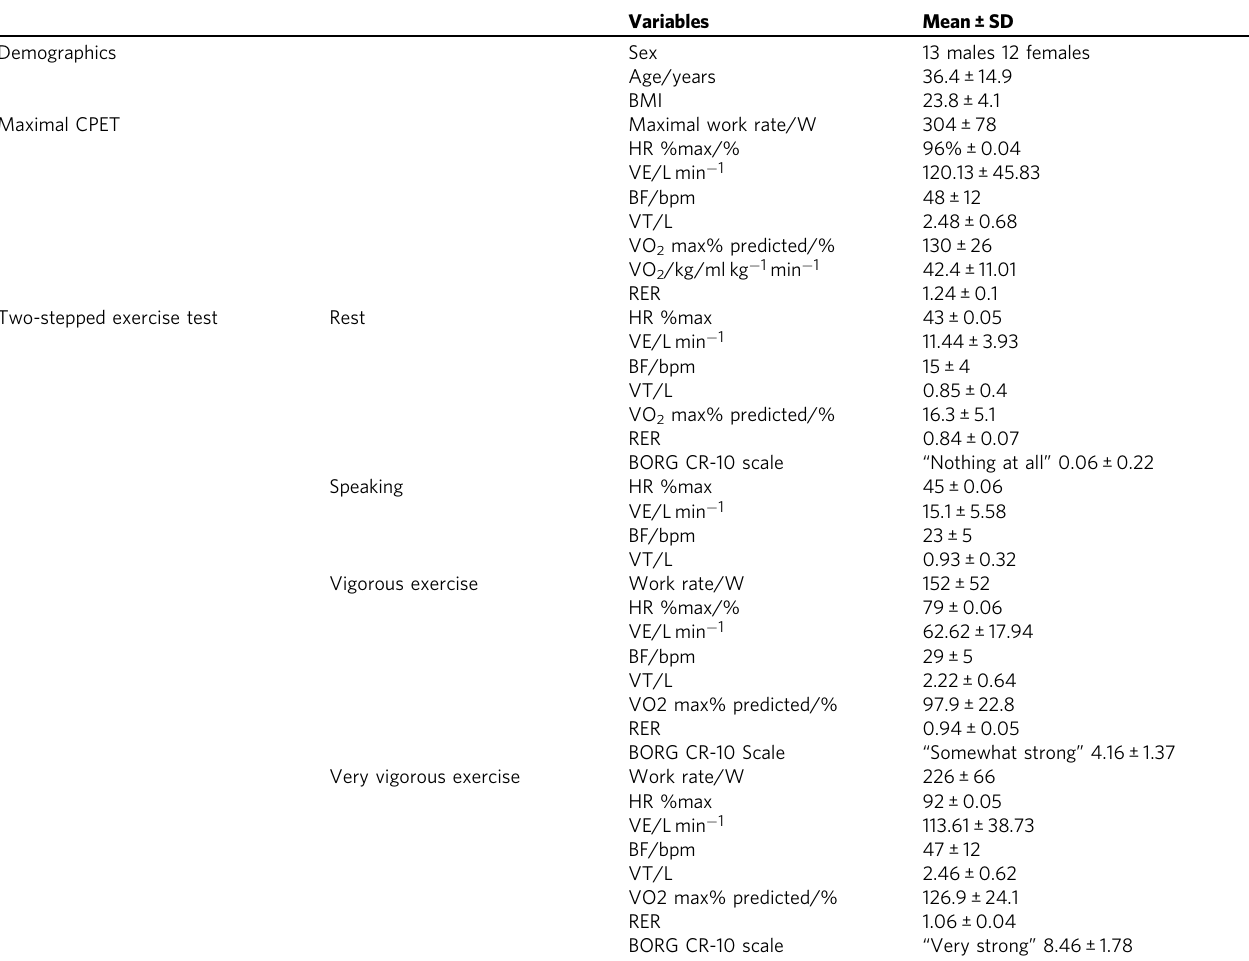
Table 1 Demographic and exercise physiology